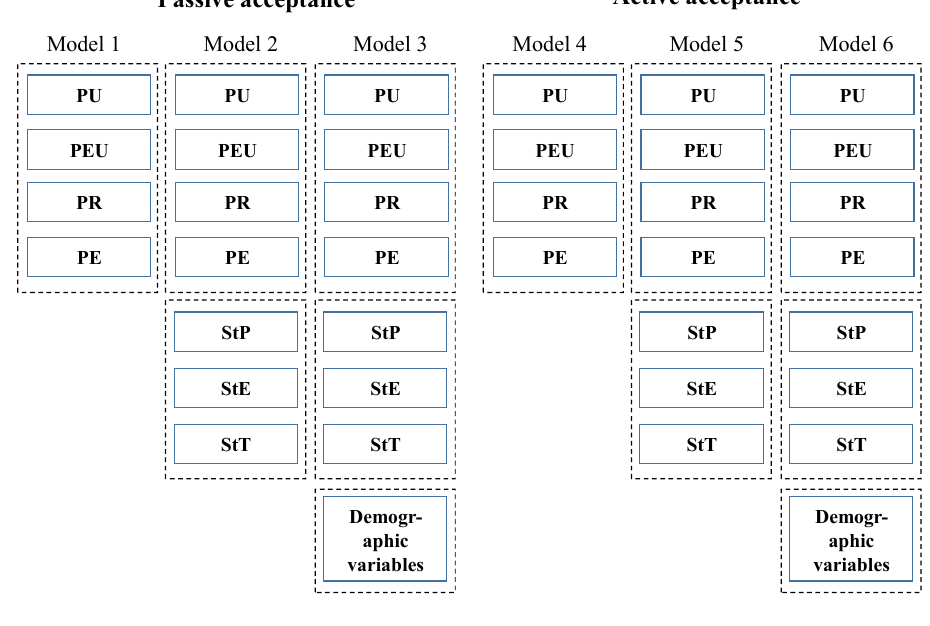
Figure 2. Research model.